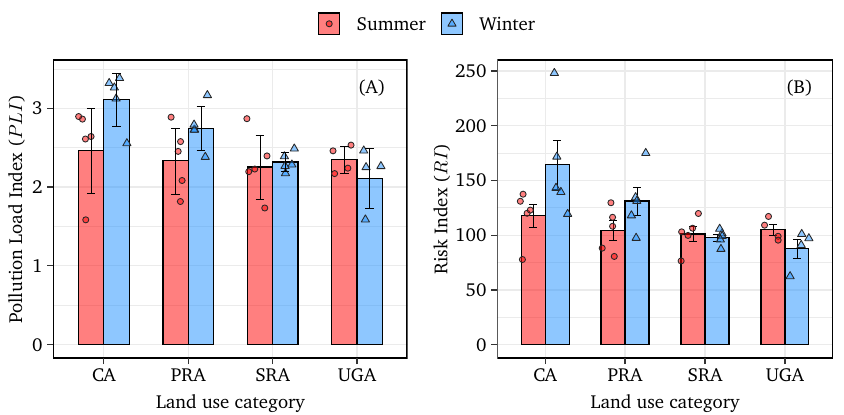
Figure 6. ( A ) Pollution load index ( PLI ), and ( B ) risk index ( RI ) of heavy metals at different land-use categories in Dhaka city. CA = commercial area, PRA = planned residential area, SRA = spontaneous residential area, and UGA = urban green area. The vertical bars represent standard